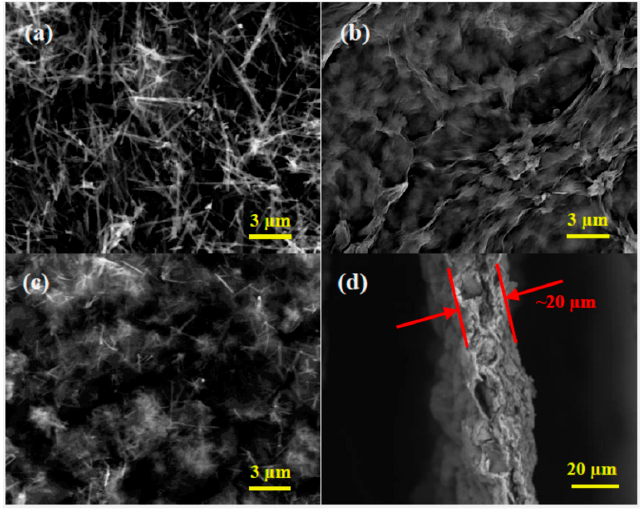
Figure 3. SEM images of LiMn 2 O 4 ( a ), graphene film ( b ), surface ( c ), and fracture edge ( d ) of LiMn 2 O 4 -graphene film.